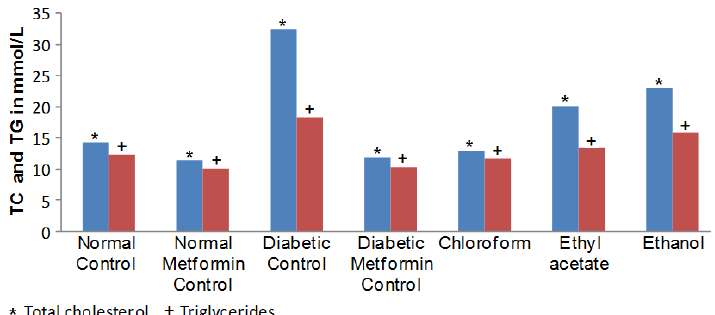
Figure 3. Effect of various of Hydrolea zeylanica on total cholesterol and serum glycerides in diabetic rats after one day